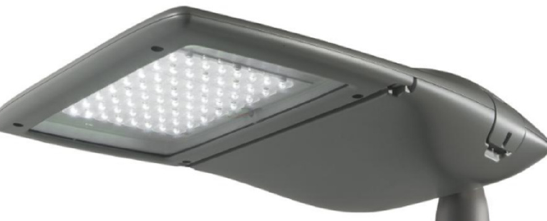
Figure 5. View of road luminaire LED_26W—manufacturer’s catalogue data. Table 2. Technical parameters of LED_26W luminaire.